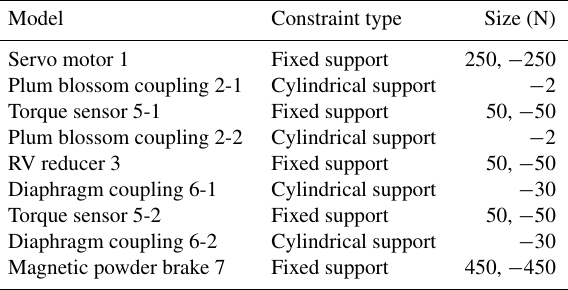
Table 3. The force parameter table of the transmission system model.